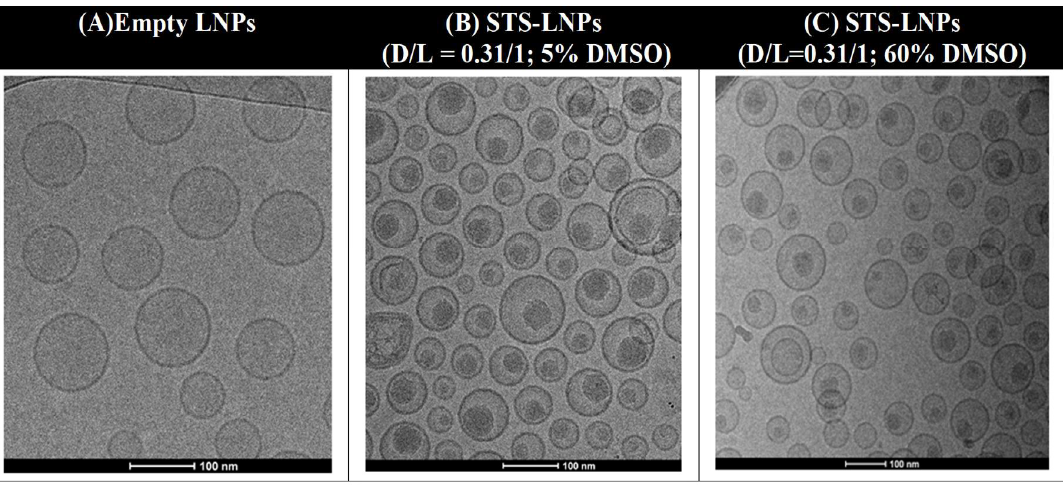
Figure 3. Cryo-TEM images of the drug free liposomes ( a ) and the staurosporine (STS)-Lipo loaded using 5% dimethyl sulfoxide (DMSO) ( b ) 60% DMSO ( c ). Scale bar represents 100 nm. Reprinted with permission from Tang et al., Pharmaceutical Research, published by Springer Nature, 2016 [24].